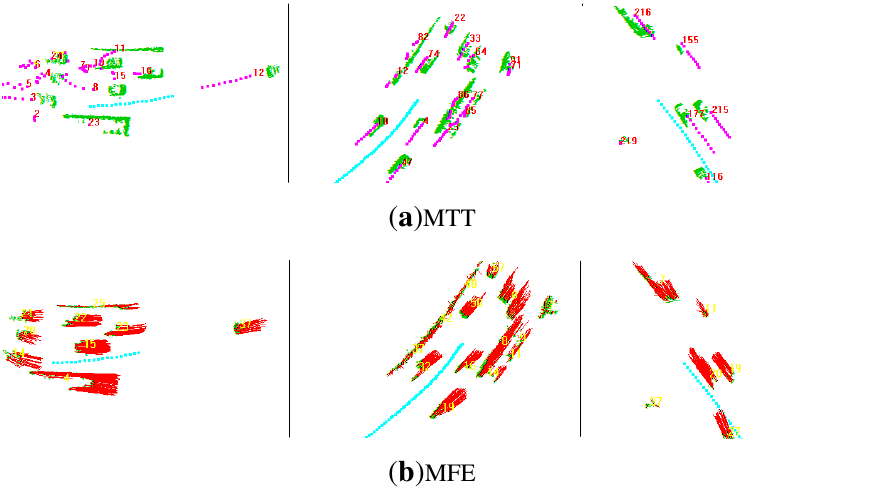
Figure 10. Comparison of multi-target tracking (MTT) and MFE. ( a ) Scenarios for MTT in which the cyan trajectory is the ego-trajectory, the green points are the moving LiDAR points and the pink trajectories represent the trajectories of targets. ( b ) Scenarios for MFE in which the cyan trajectory is the ego-trajectory, the green points are the moving LiDAR points and the red lines stand for the velocity vectors of moving grids. The MTT just calculates the motion state of each detected target constituted by grid clusters, but the MFE estimates the motion state of each grid.